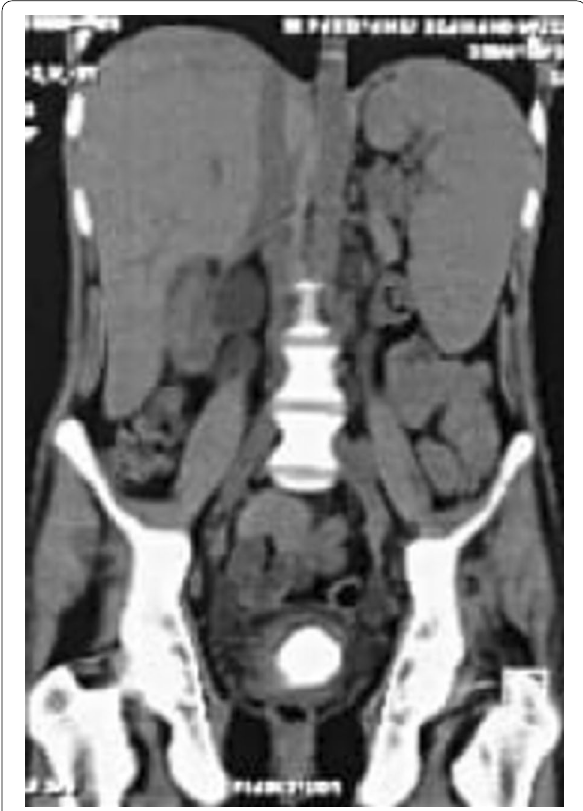
Fig. 1 CT KUB showing large bladder stone and bilateral hydroureteronephrosis